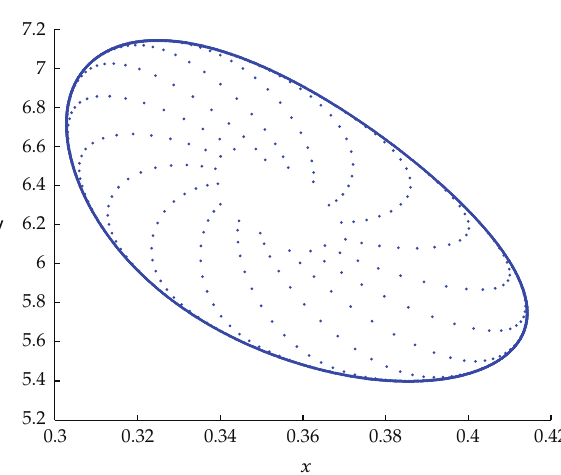
Figure 20: Phase portrait for the system (cid:3) 2.2 (cid:4) for a (cid:8) 3 . 5, b (cid:8) 0 . 2, and d (cid:8) 2 . 81.